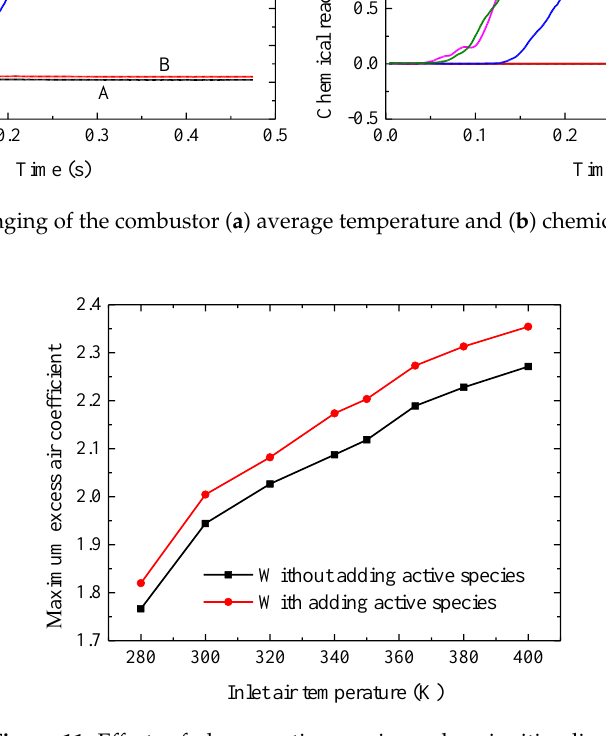
Figure 11. E ff ects of plasma active species on lean ignition Figure 11. Effects of plasma active species on lean ignition limit.